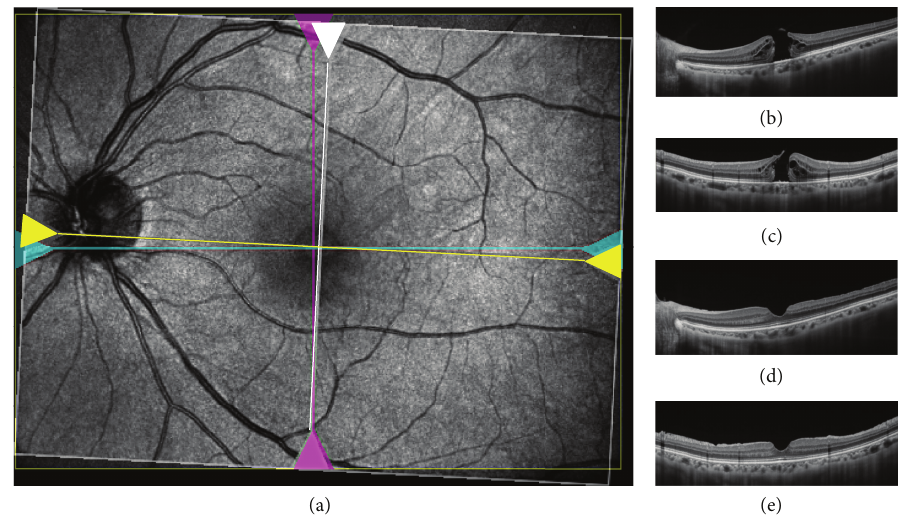
Figure 1: (a) Composite infrared image made by overlapping preoperative and postoperative images (case 6). Yellow line and white line indicate preoperative location of the horizontal and vertical scan (b, c). Blue line and pink line indicate postoperative location of the horizontal and vertical scan (d, e). Center of MH and fovea were identified by moving the location of scans (yellow, white, blue, and pink lines). The fovea has shifted toward the optic disc after MH